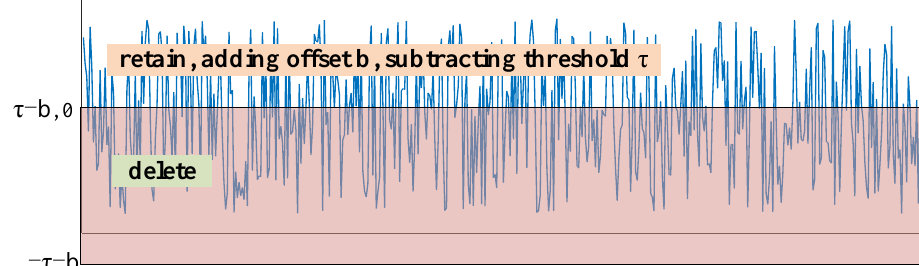
Figure 14. The soft threshold function when b = τ .